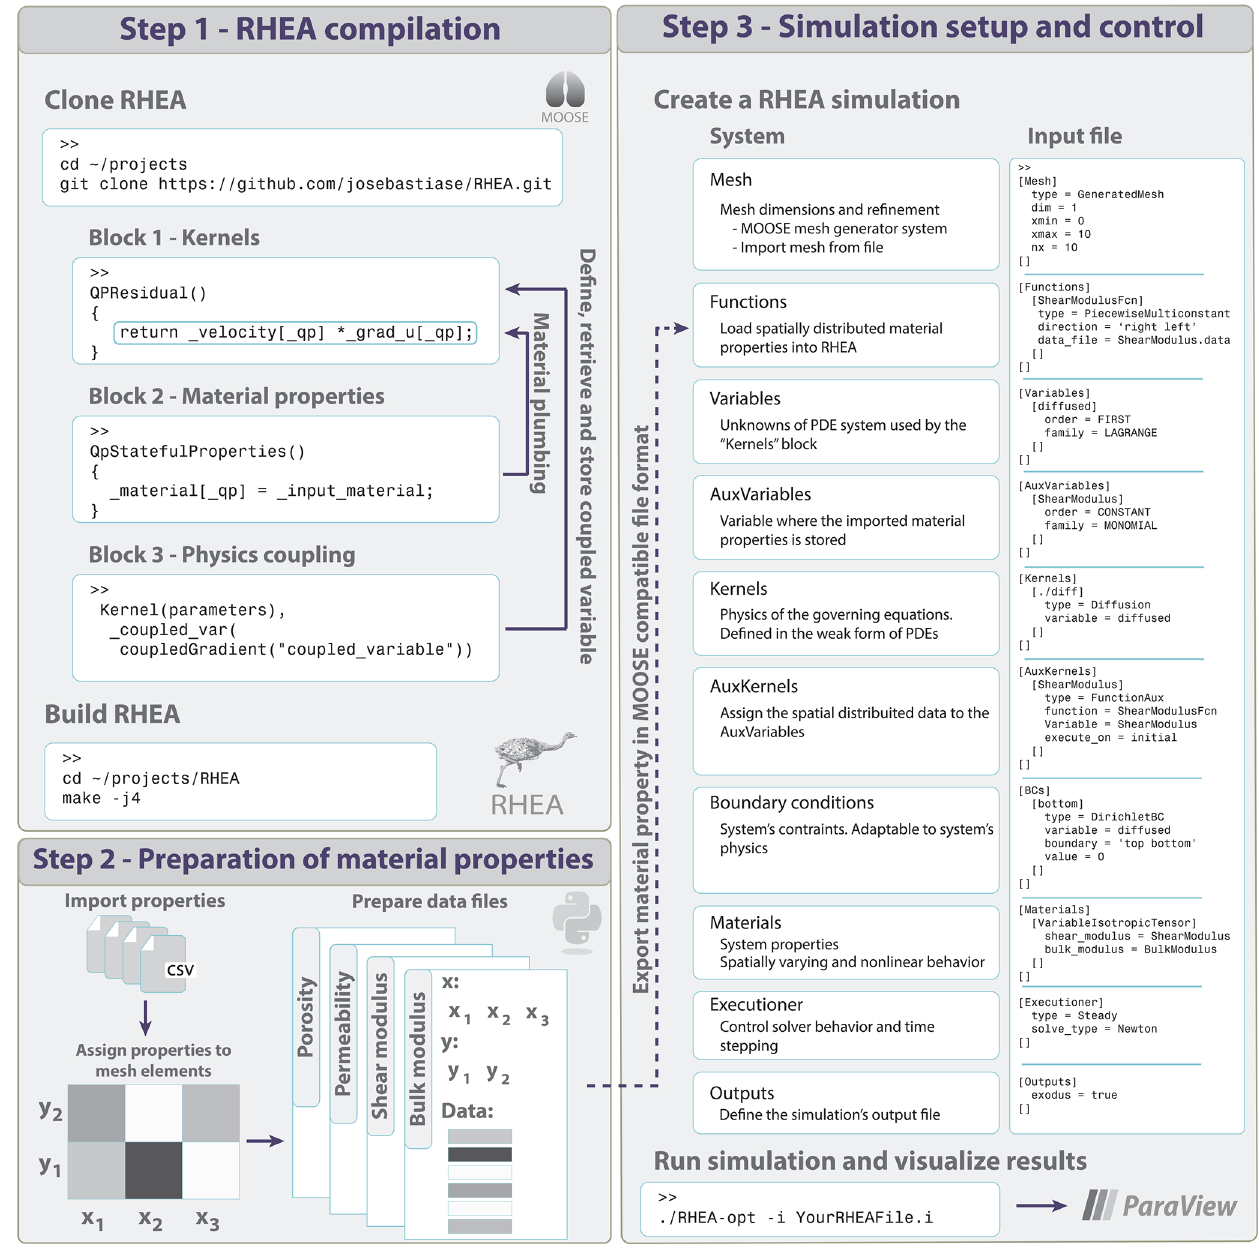
Figure 1. Visual illustration of the steps required to create RHEA, generate distributed material properties files and write a simulation